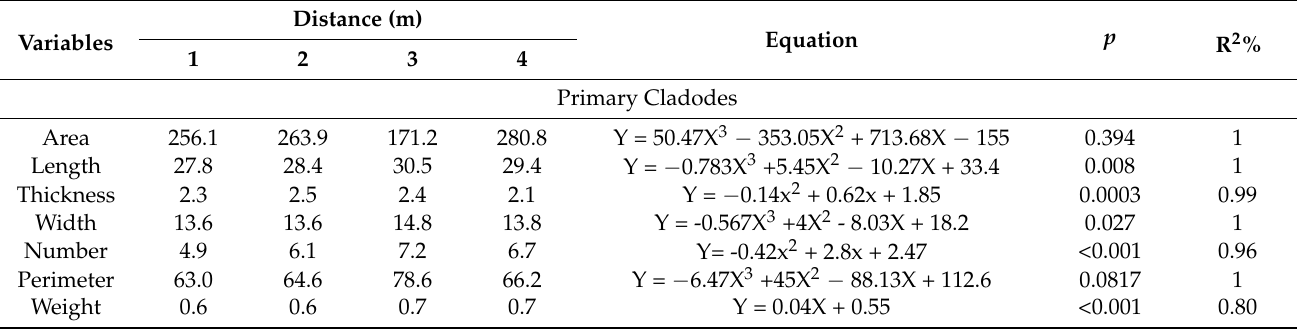
Table 6. Morphological characteristics of primary and secondary cladodes of forage cactus at different distances from